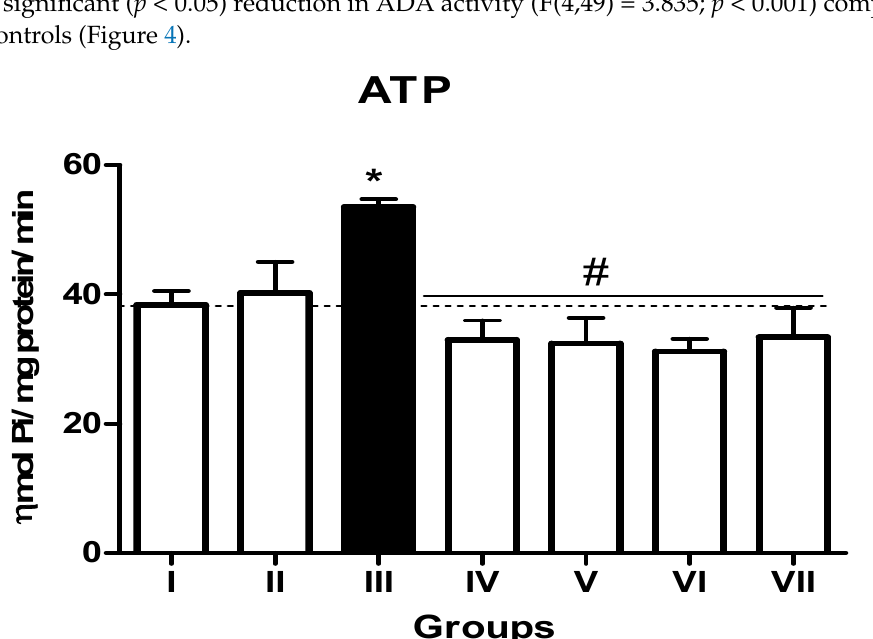
Figure 1. E-NTPDase (ATP as substrate) activity in platelets of L-NAME-stressed rats treated with tiger nut and walnut supplemented diets. Data are presented as mean ± SEM ( n = 10). The bars with various symbols are statistically different ( p < 0.05). * represents a significant difference from the control (I) group. # represents a significant difference from the ED (III) group (one-way ANOVA followed by post hoc Tukey, *, # denote p < 0.05, Key: Group I: Normal control placed on a basal diet; Group II: Positive control placed on a basal diet/L-NAME/Viagra (5 mg/kg/day); Group III: ED-induced group placed on a basal diet/L-NAME (40 mg/kg/day); Group IV: